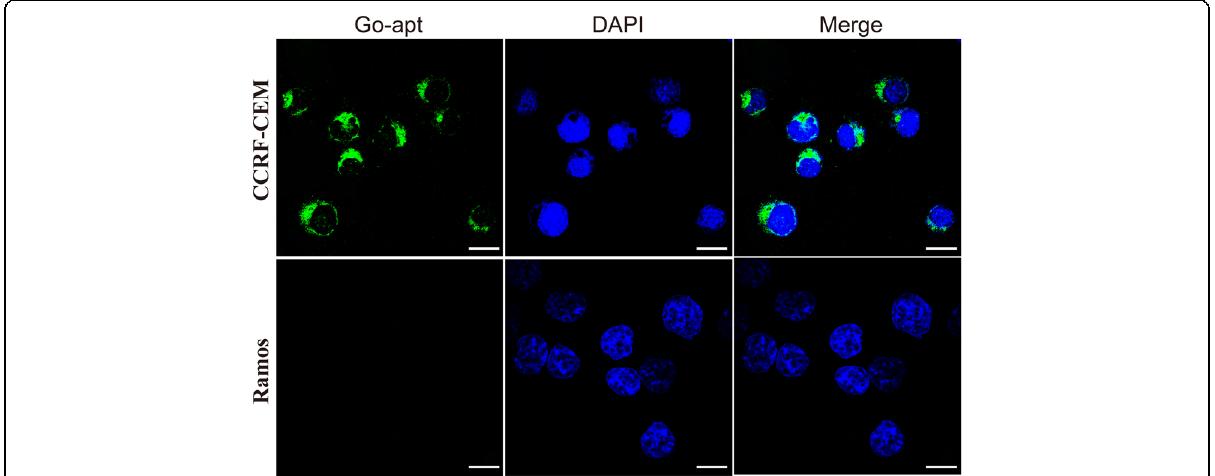
Fig. 4 Fluorescence micrographs of CCRF-CEM and Ramos cells after mixing with GO-apt. Nuclei were stained with DAPI. Scale bars indicate 25 μ